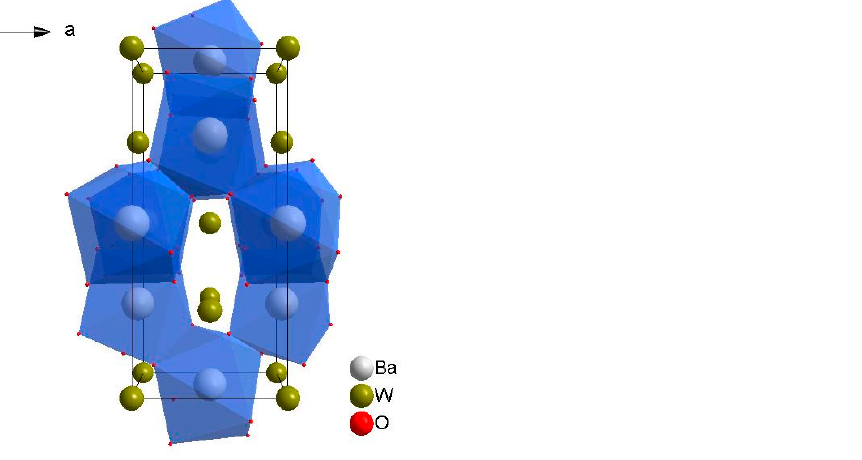
Figure 1. Unit cell structure of BaWO 4 viewed along the b axis with marked dodecahedrons [BaO 8 ] (blue).